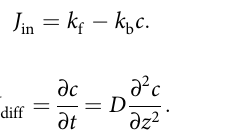
model that considers only one type of silica species, being either bound to the solid or dissolved in water and getting displaced by diffusion with the corresponding overall forward and backward rates k f , k b and the diffusion coef fi cient ( D ). Equations 1, 2 pro- vide the expressions for the corresponding interfacial and diffu- sive fl ux. The interfacial fl ux ( J in ) depends on k f , k b , and the interfacial concentration of dissolved species ( c ). The diffusive fl ux ( J diff ) depends on D and the concentration gradient ortho- gonal to the surface plane.